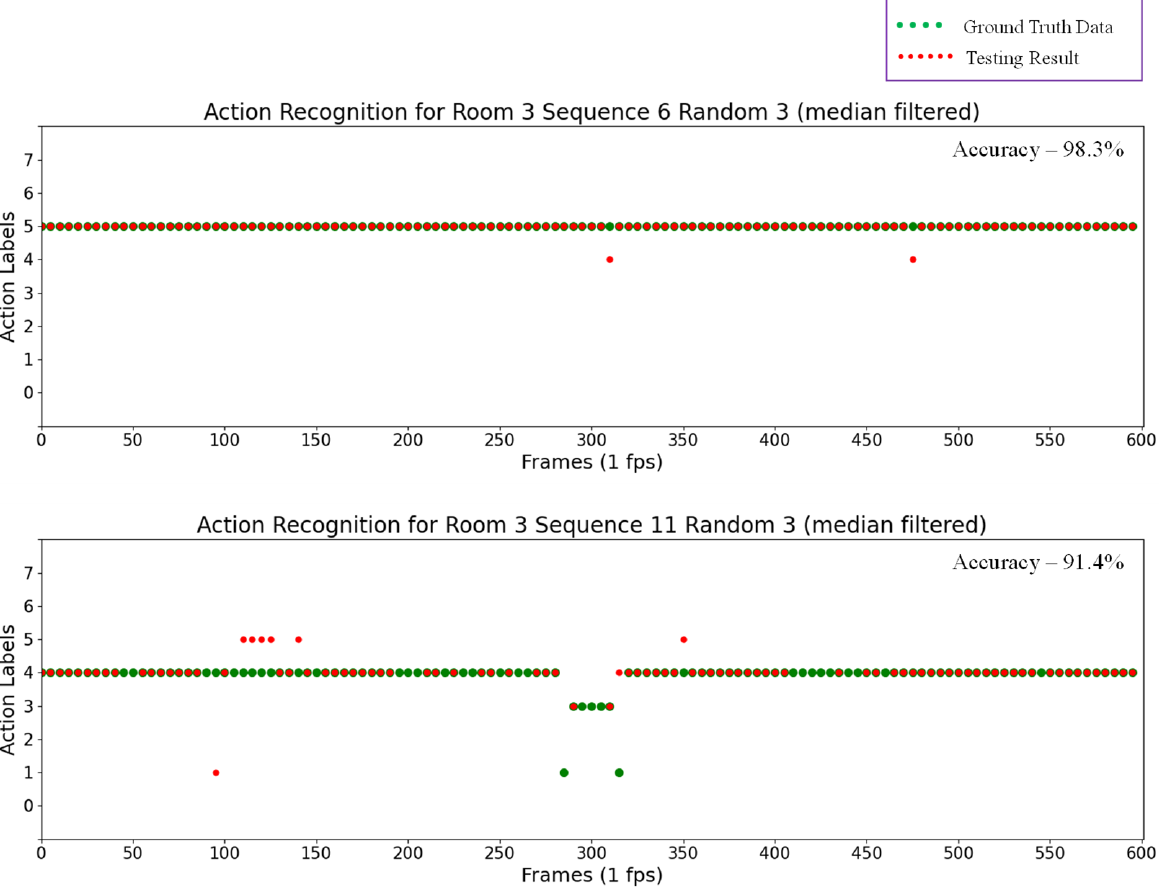
Figure 17. Action recognition results after applying filter for Room 3 Sequence 6 Random 3 ( top ) and Room 3 Sequence 11 Random 3 ( bottom ).